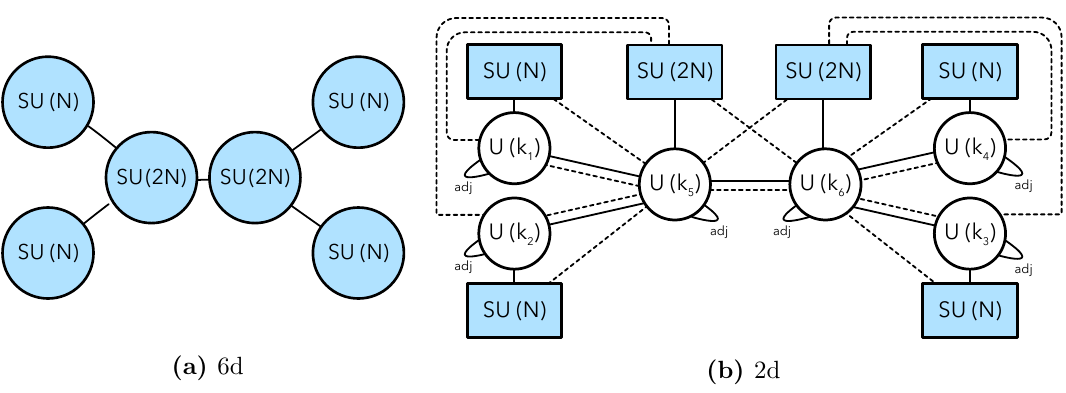
Figure 4. Quiver diagrams for 6d/2d gauge theories on D6/D2-branes at n =